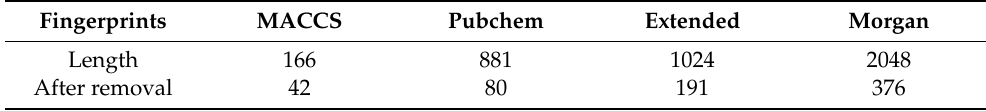
Table 1. Length of fingerprints after variance